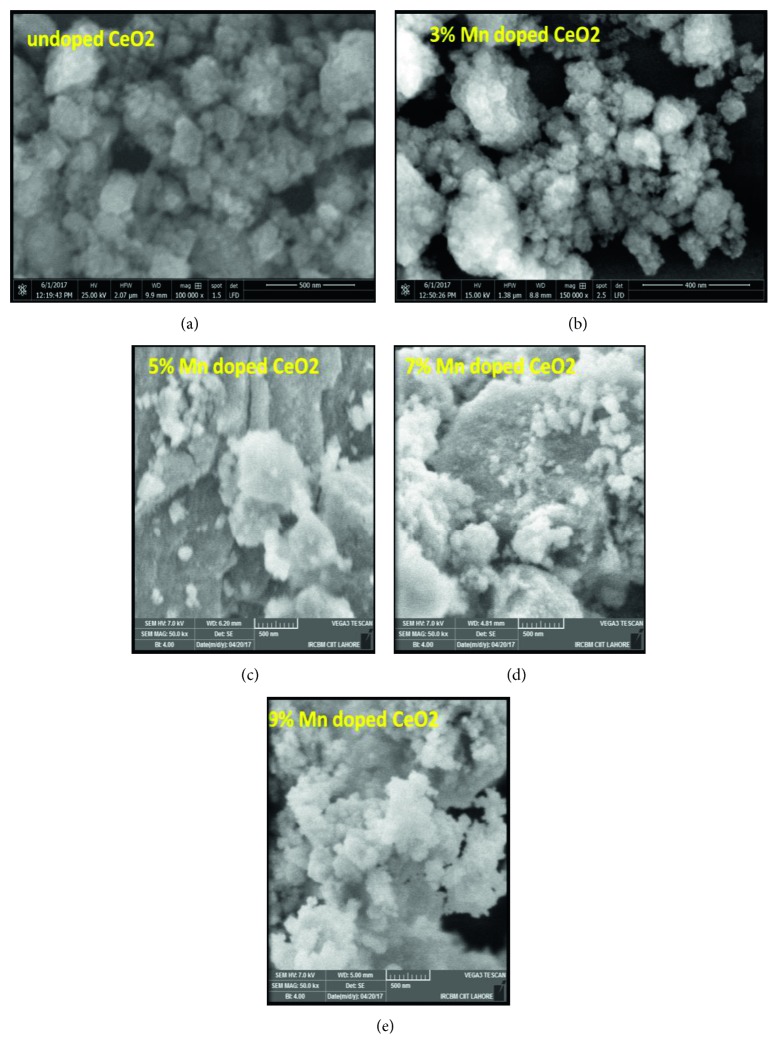
Morphology of the MnxCe1−xO2 nanocomposite: (a) undoped CeO2, (b) 3% Mn-doped CeO2, (c) 5% Mn-doped CeO2, (d) 7% Mn-doped CeO2, and (e) 9% Mn-doped CeO2.